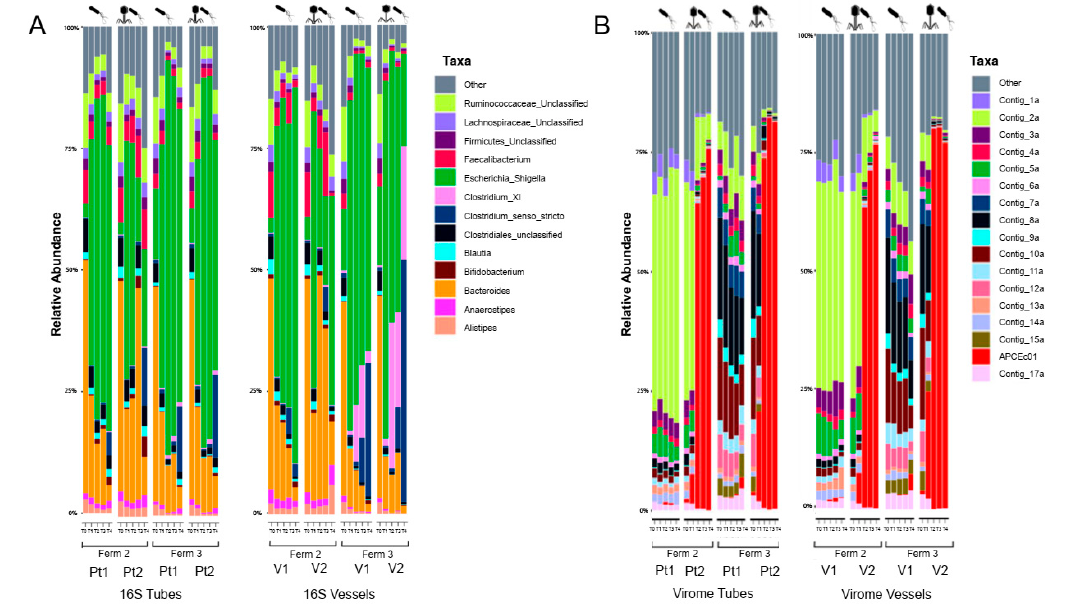
Figure 3. Sequencing results of faecal fermenter tubes and vessels during treatment 3 ( E. coli APC106 addition vs. E. coli APC106 + viable Φ APCEc01 addition; fermentation 2–FSI batch1, fermentation 3–FSI batch2) ( A ) stacked bar plots showing different bacterial abundances on genus level ( B ) stacked bar plots showing different viral abundances.